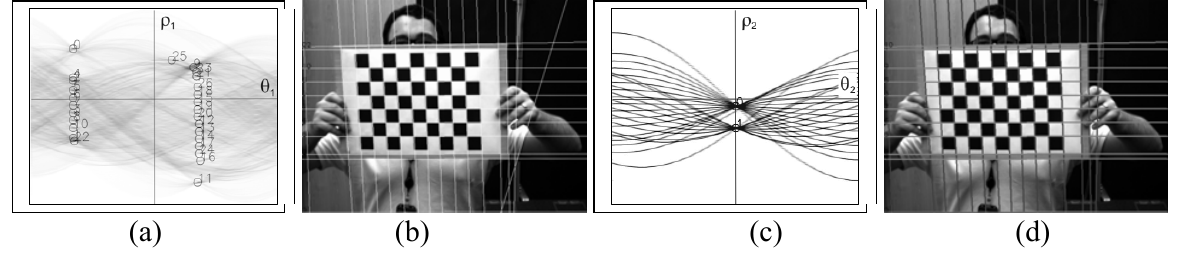
Figure 8. Initial detection of the set of lines.